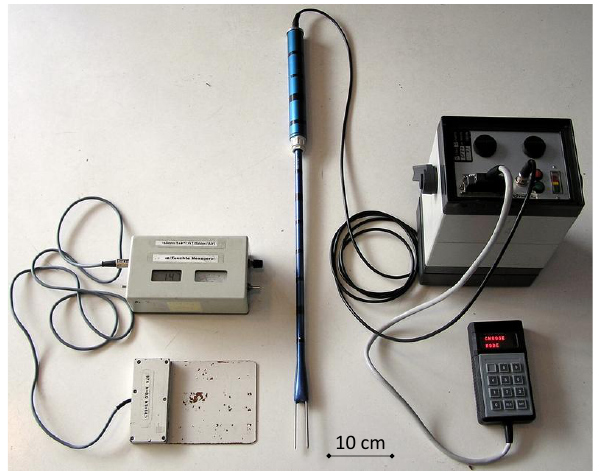
Fig. 1. Denoth (left) and Snow Fork (right) measurement devices.